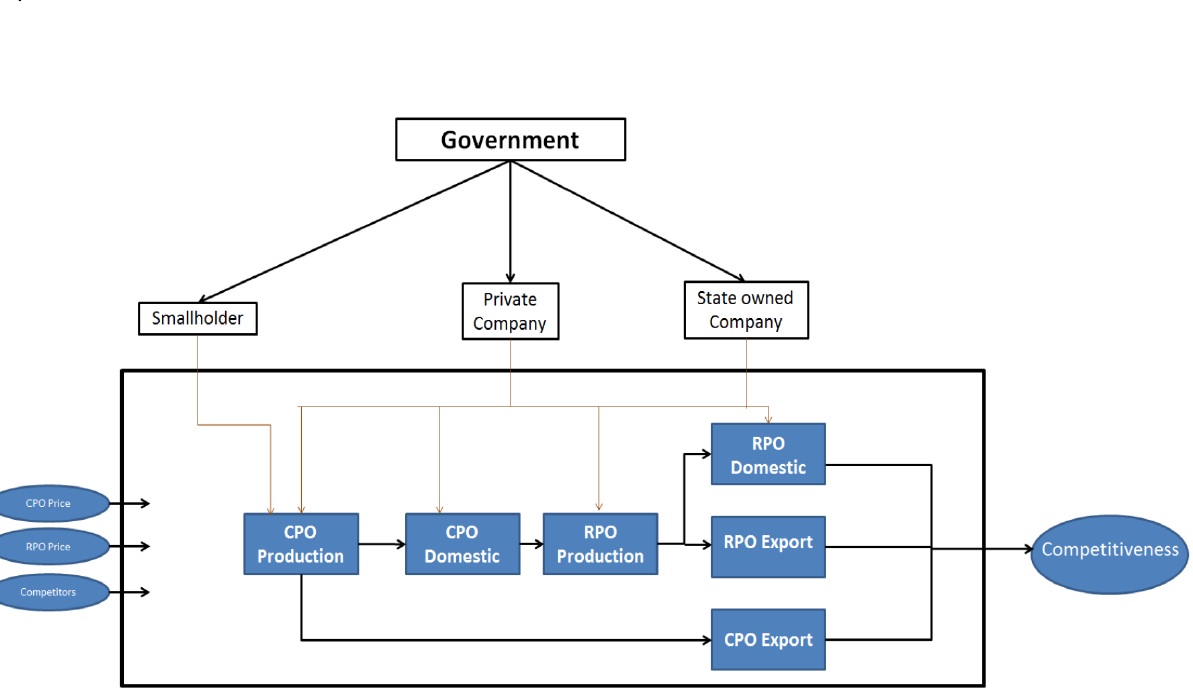
Figure 5. Conceptual Model of Palm Oil Industry